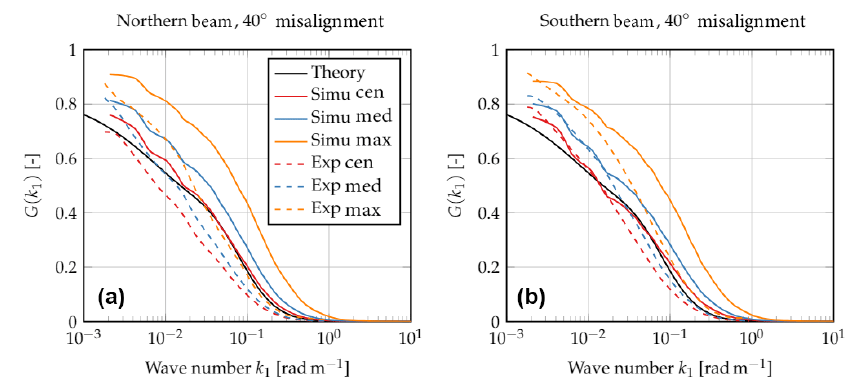
Figure 7. Transfer function G(k 1 ) for misaligned beams for the northern beam data ( a ) and southern beam data ( b ) using 20 simulations and 2 months of experimental data at a sampling rate of 1Hz.